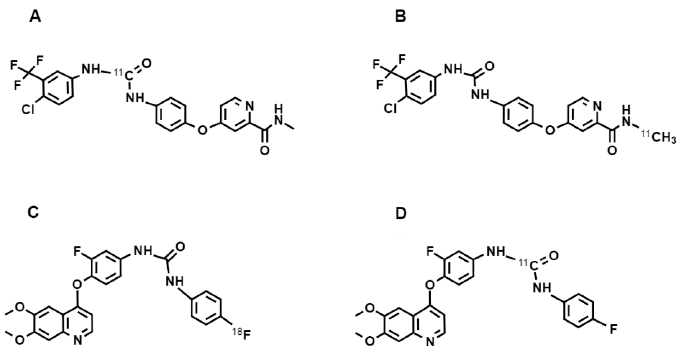
Figure 4. Sorafenib-based and diaryl urea-based VEGFR imaging agents; ( A ): [ carbamate - 11 C]-sorafenib [261,262]; ( B ): [ N-methyl - 11 C]-sorafenib [262]; ( C ): [ 18 F]F-diaryl urea [263]; ( D ): [ carbamate - 11 C]-diaryl urea [264].